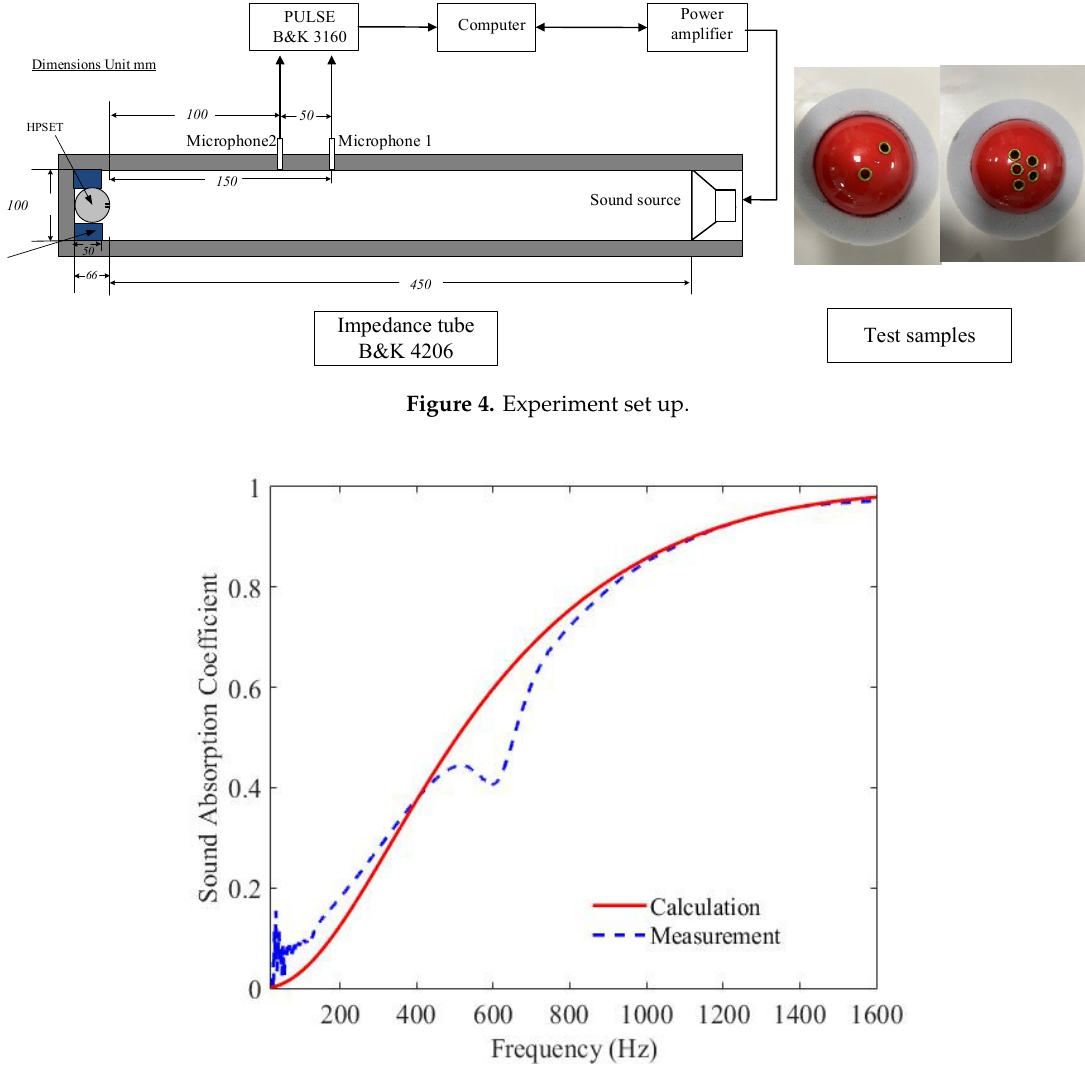
Figure 4. Experiment set up. Table 2. Parameters of the tested samples of HPSETs.